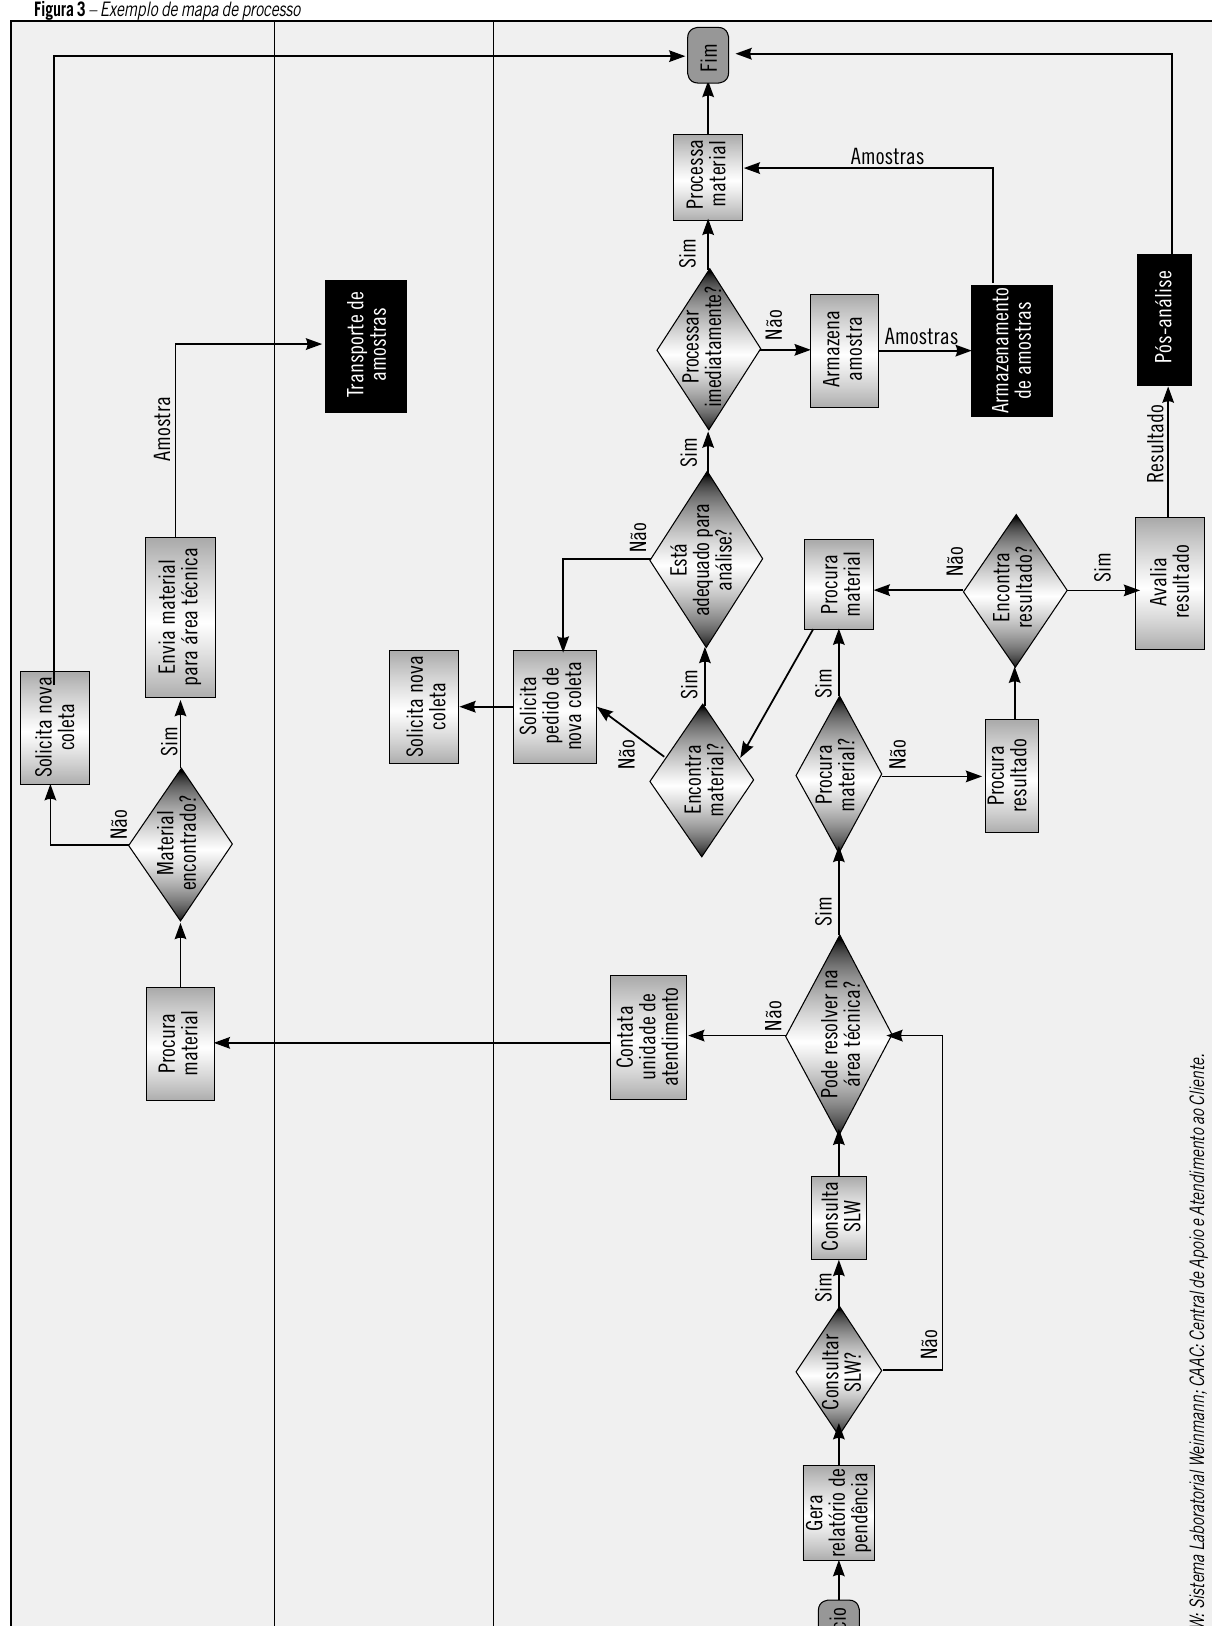
Figura 3 – Exemplo de mapa de